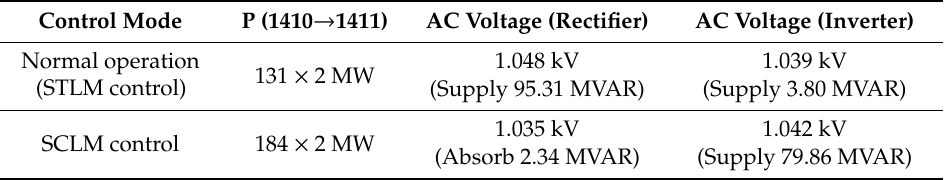
Table 8. Comparison of system losses by operating change (transformer overload case). Table 9. HVDC setpoint change using the SCLM control for line